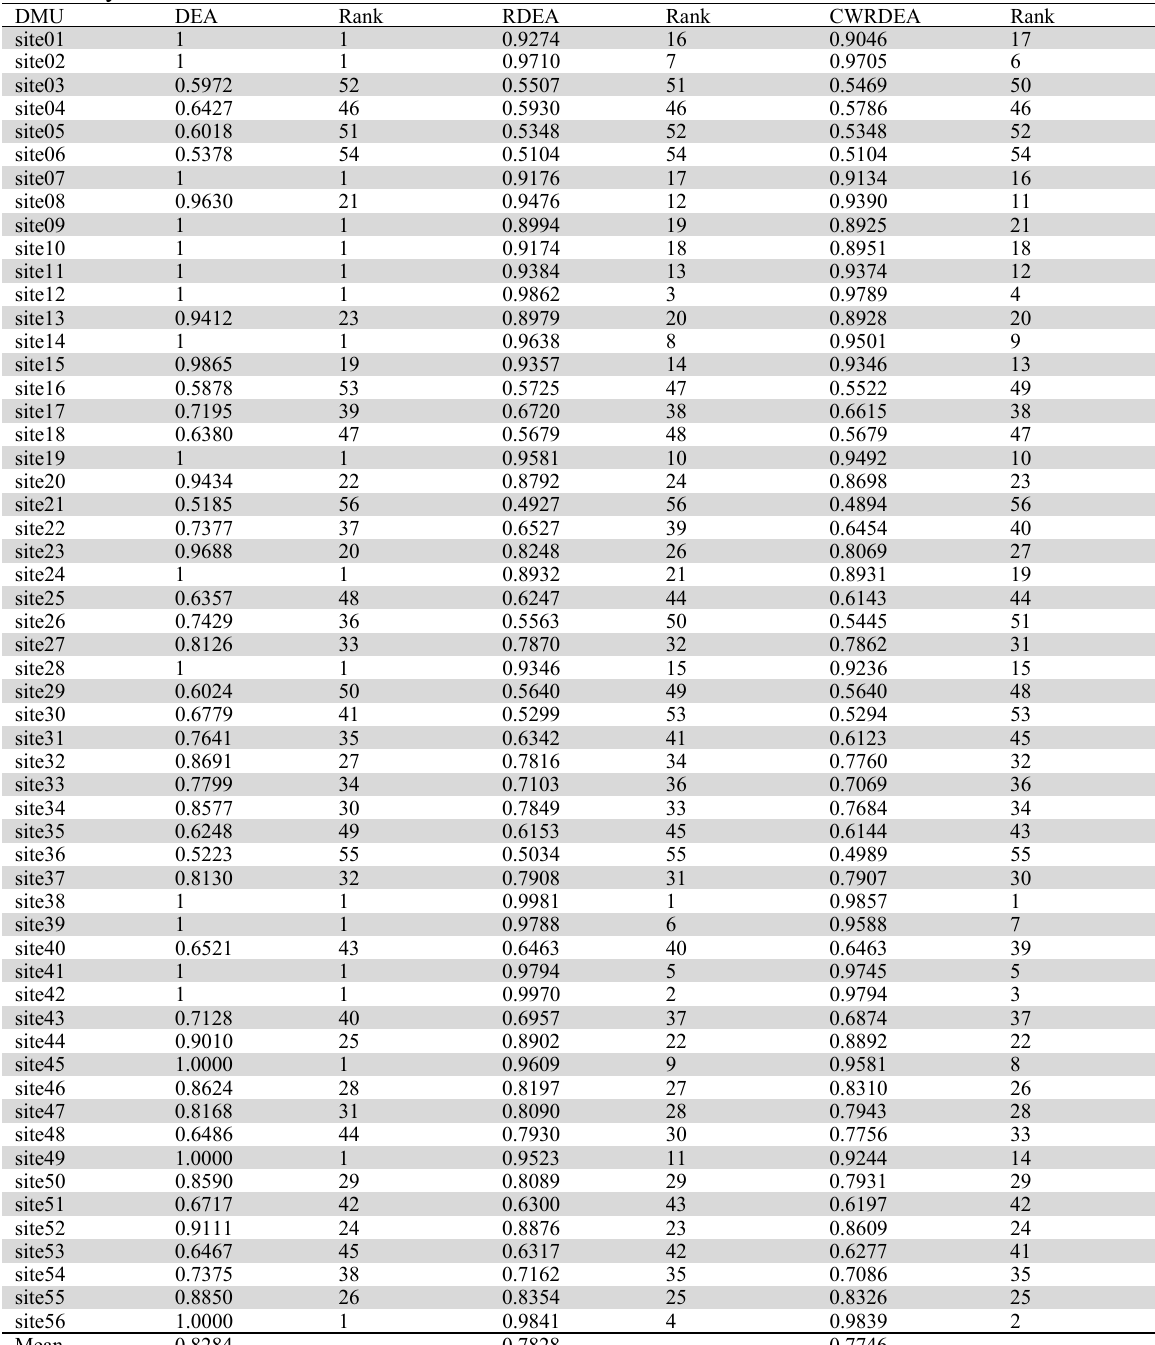
Efficiency of different DMU in different DEA